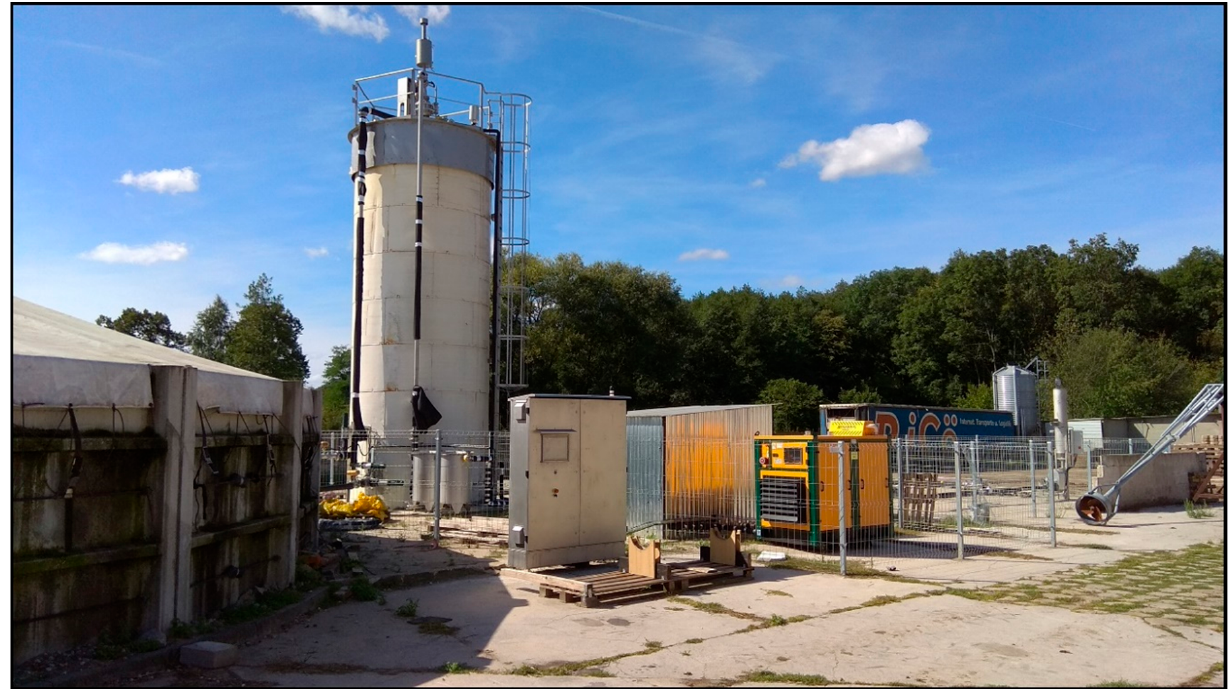
Figure 3. View of the biogas plant with a fermenter equipped with a hybrid pump.